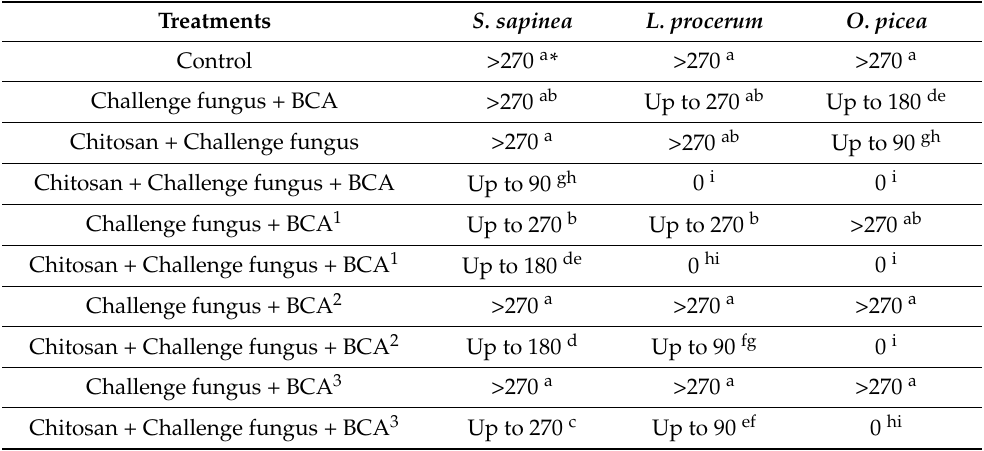
Table 2. Presence of challenge fungus in the wood cell depth ( µ m) after 24 days of incubation (n = 5).